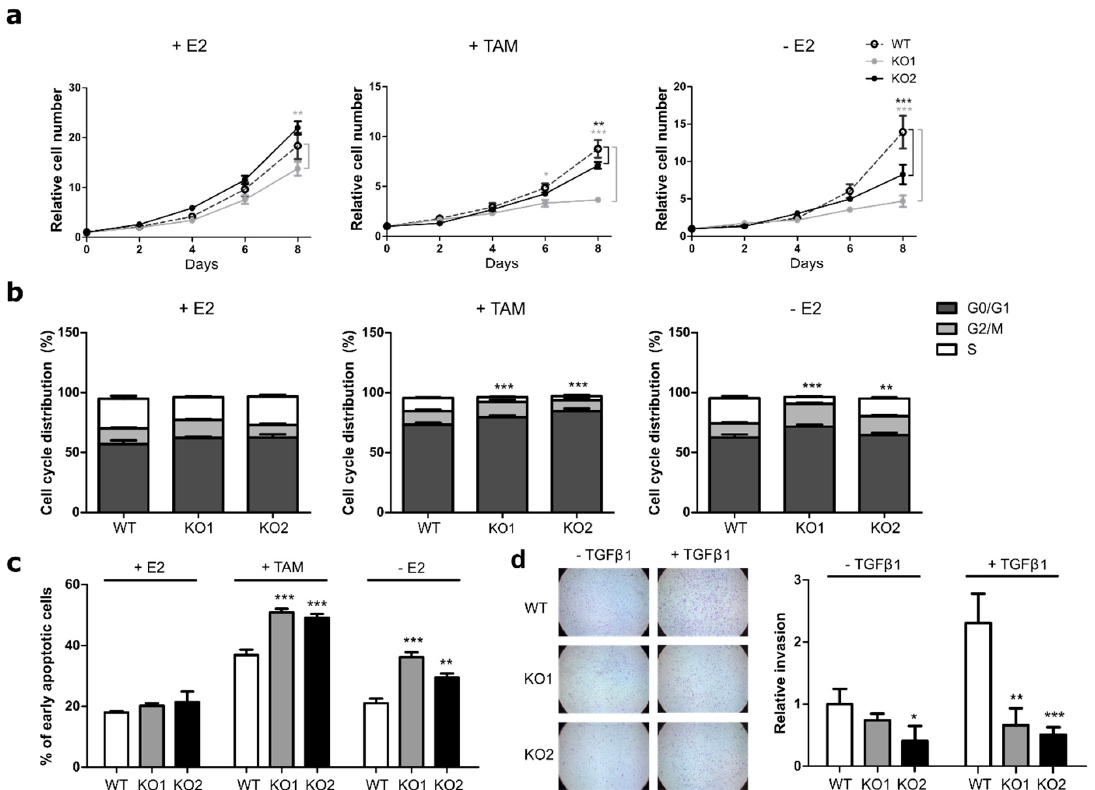
Figure 2. ATF3 knockout increases sensitivity to endocrine therapy. ( a ) Cell proliferation of MCF7 cells treated for eight days with E2, TAM, or deprived from E2 and measured at indicated time points with nuclei count in fluorescent microscopy. All values are normalized to a seeding control. ( b ) Cell cycle distribution of MCF7 cells treated for four days with E2, TAM or without E2. Plots represent the percentage of cells in the di ff erent cell cycle phases determined by BrdU / 7AAD staining. Statistics performed on the S phases (white bars) ( c ) Measurement of apoptosis rate in MCF7 cells treated for four days with E2, TAM, and without E2. Plots represent the percentage of early apoptotic cells determined by Annexin V / PI staining. ( d ) Representative microscopy images of transwell invasion assay through Matrigel and relative quantification of the number of invading cells. Values are expressed as relative to the unstimulated WT control. Data are represented as mean ± SEM, n = 3. *** p -value < 0.001, ** p -value < 0.01, * p -value < 0.05.